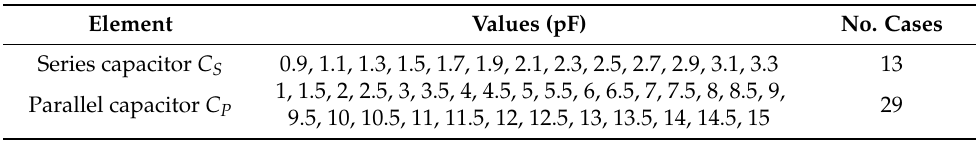
Table 1. Capacitor values in matching circuit for